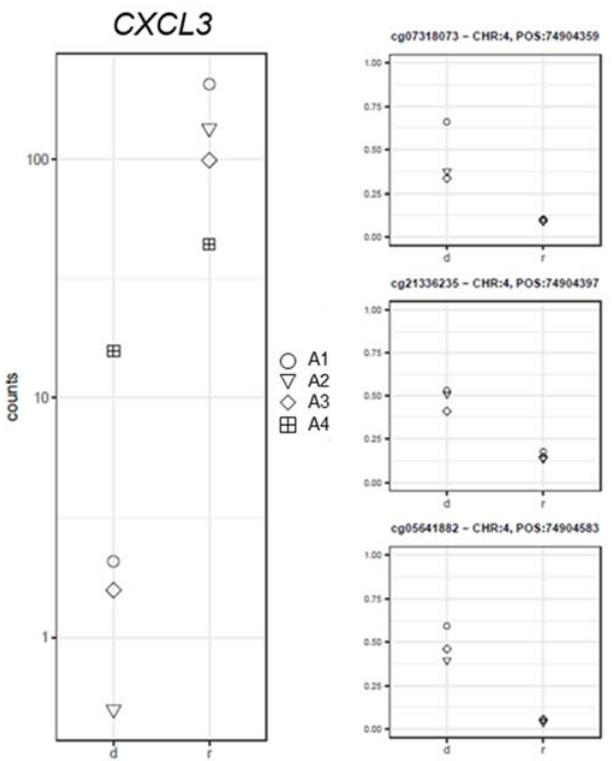
Figure 6. Gene expression (left panel) and corresponding methylation level (right panel) comparison between the samples at diagnosis (d) and remission (r) for the CXCL3 gene.